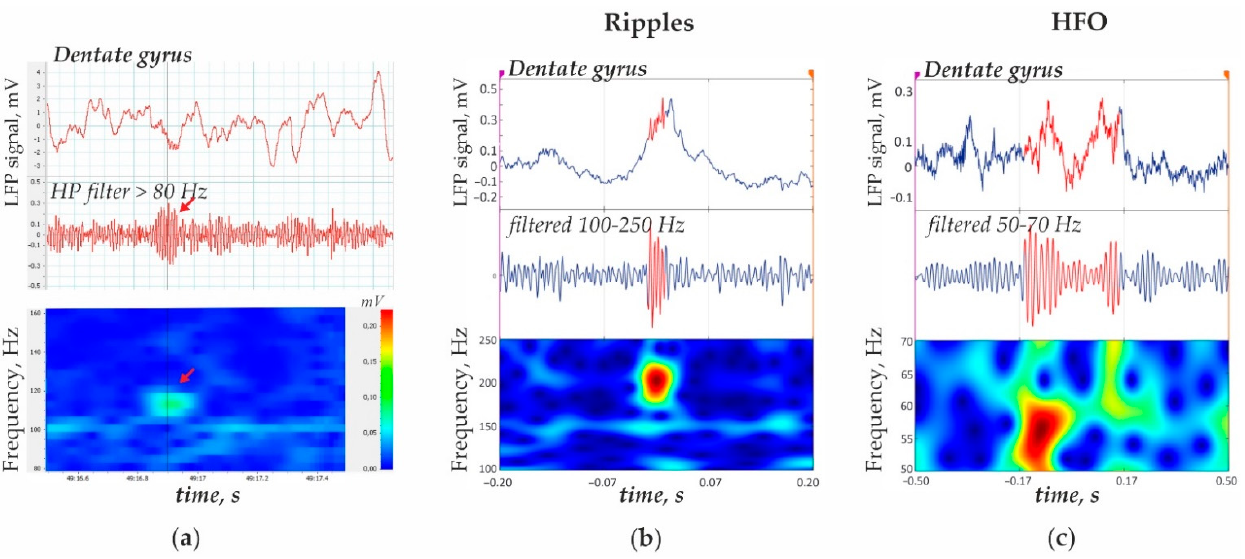
Figure 1. Representative hippocampal ripples and 50–70 Hz high frequency oscillations (HFO) in time and frequency domains. ( a ) Ripple oscillation in the dentate gyrus LPF could be visualized in the filtered signal and in the time-frequency plot (red arrow). The amplitude spectrum was plotted with a fast Fourier transform (length 512, window overlap 93.75%). ( b ) Ripple oscillation detected by means in RIPPLELAB. ( c ) High frequency oscillation 50–70 Hz (HFO) detected by means of RIPPLELAB.